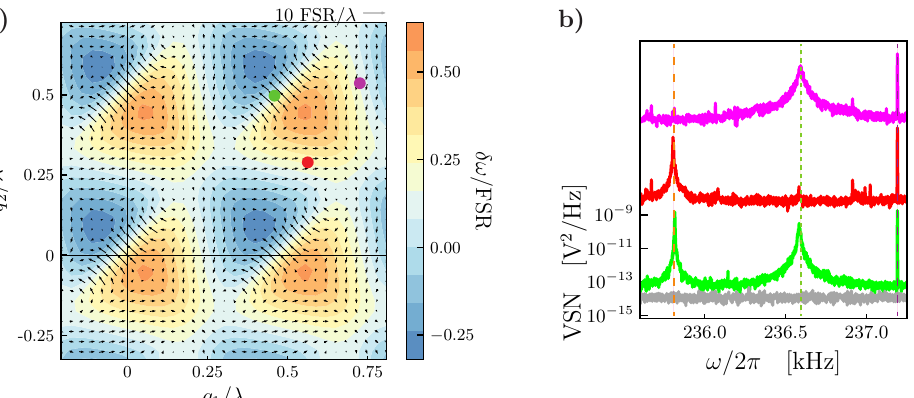
Figure 3. ( a ) Contour plot of the cavity frequency shift ( δω ) normalized to the free spectral range (FSR) of the cavity, as a function of the membrane positions q 1 and q 2 normalized to the wave- length, due to the presence of the two-membrane etalon. Superimposed the vector plot of the gradient field of the frequency shift, whose components give the two optomechanical couplings, with the unit indicated on the top right of the panel. The green, red and blue dots represent the points where the mechanical spectra of the fundamental modes of the two membranes were measured [see panel ( b )]. ( b ) Thermal voltage spectral noise (VSN) of the membrane sandwich obtained by homodyne detection of the light reflected by the optical cavity. Bottom: the funda- mental modes of both membranes are coupled to the optical cavity. The magenta–dashed line indicates the beat note added for calibration. For the left mode (orange–dashed line) we determine: ω m 1 = 2 π × 235.810 kHz, γ m 1 = 2 π × 1.64 Hz, and g 1 = 2 π × 0.30 Hz; for the right mode (green– dashed line): ω m 2 = 2 π × 236.580 kHz, γ m 2 = 2 π × 9.37 Hz, and g 2 = 2 π × 0.28 Hz. Middle: only the membrane with lower frequency fundamental mode is coupled to the optical field. Top: only the membrane with higher frequency fundamental mode is coupled to the optical